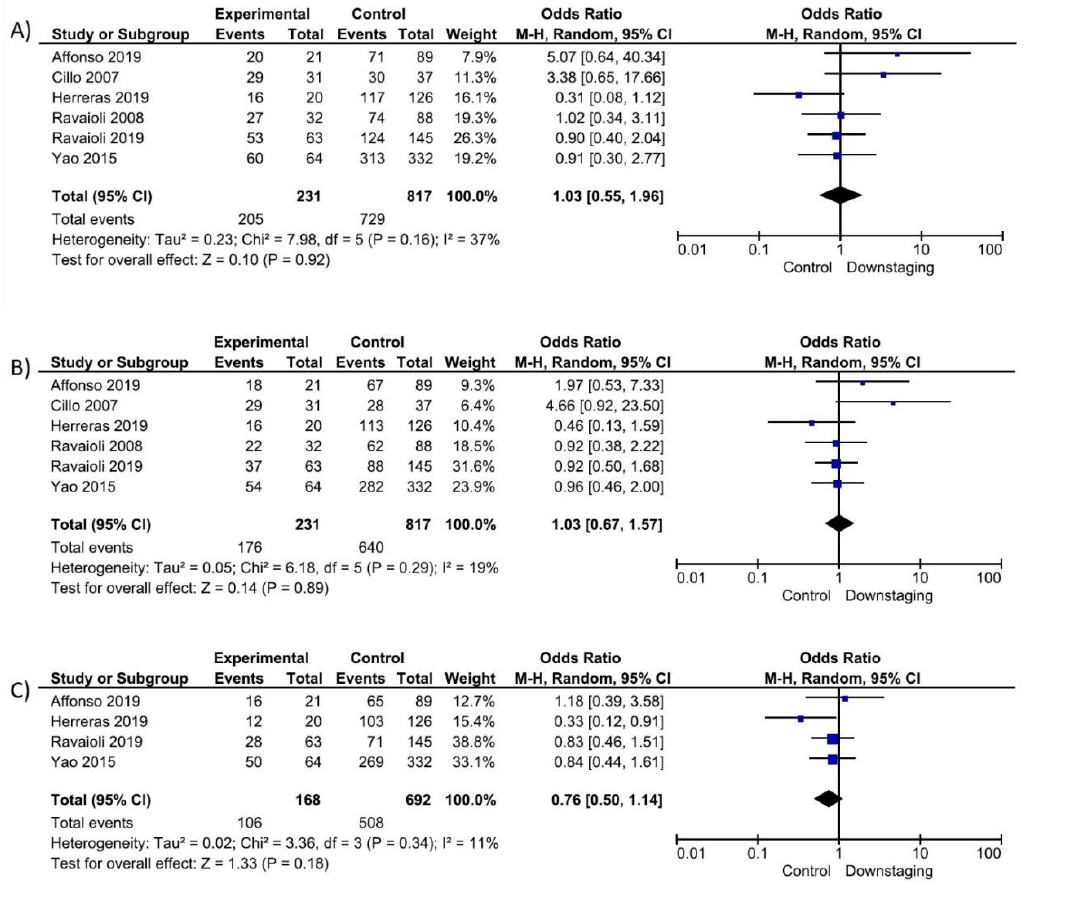
(d) Sensitivity (c)